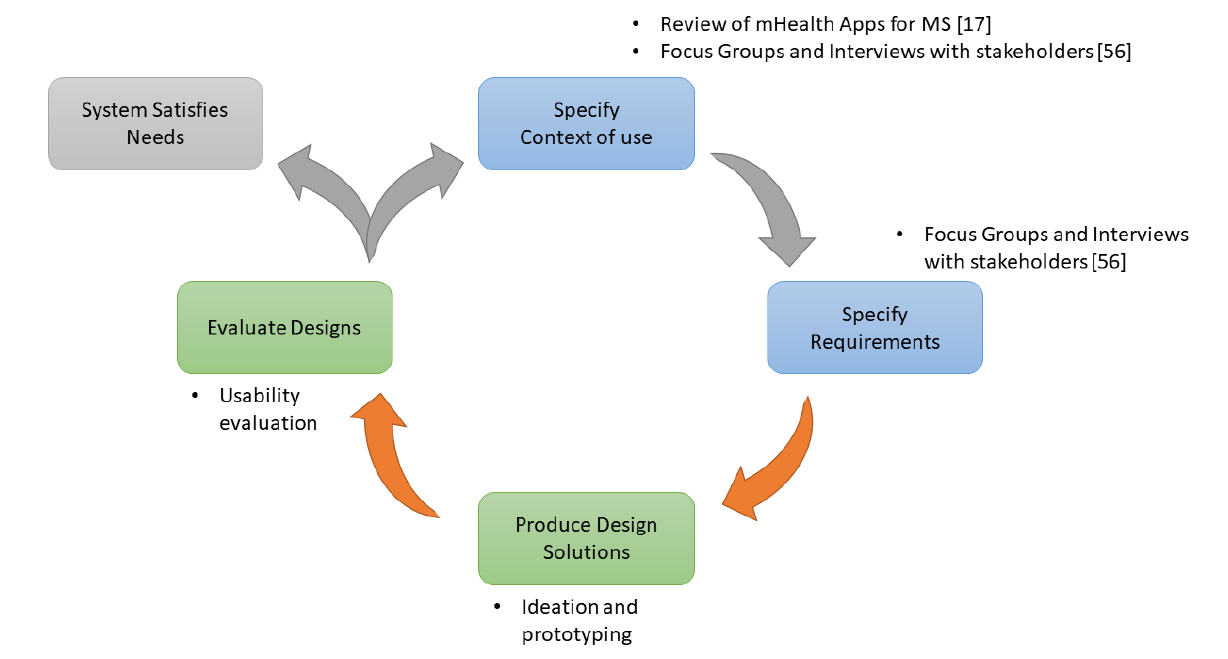
Figure 1. Phases of user-centered design. Green represents the areas covered in this study. Detailed results of our mobile health (mHealth) app review for multiple sclerosis and focus groups and interviews with stakeholders can be found in their respective